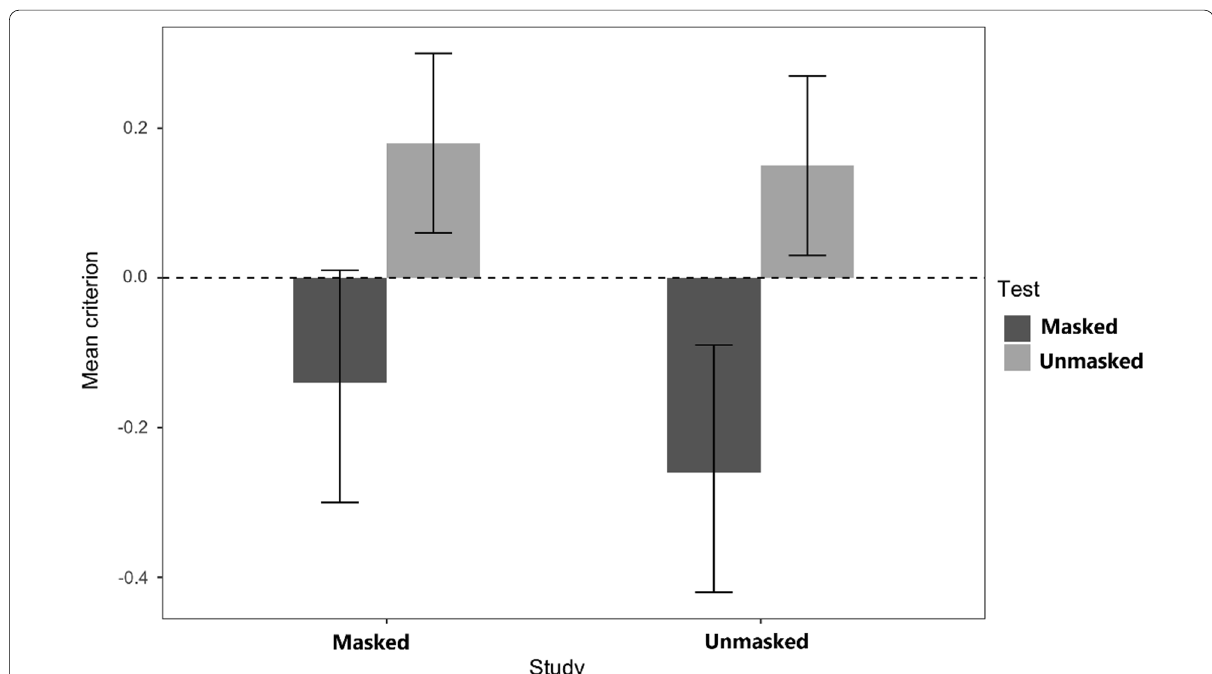
Fig. 8 Experiment 3: Criterion c. Note . Mean response criterion used for all participants regarding faces studied with and without a mask and subsequently tested either with or without a mask (Experiment